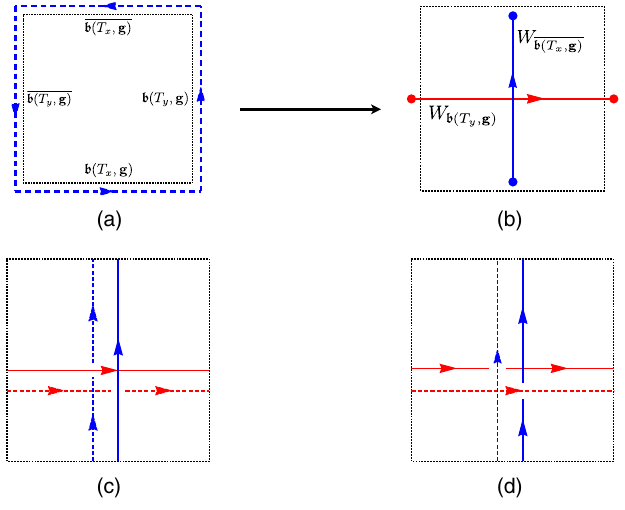
FIG. 7. (a) In the toric code with unconventional symmetry, Z defects exist at the end points of a defect branch line (indicated by the dashed line), which is produced by conjugating the spins on the vertical links on one side of the branch line by σ z for terms in the Hamiltonian that straddle the branch line. This changes − A ↦ þ A for vertex terms straddling the branch line, ener- v v getically favoring an e quasiparticle (indicated by solid black dots) at those vertices. (b) The configuration obtained from that in (a) by acting on the system with the translation operator R (c) The configuration obtained from (a) by adiabatically trans- porting the defect in the ˆ x direction by one lattice spacing. In this case, the topological charge of the defect must change from I e . (d) The configuration obtained from that in (c) by adiabati- Z cally transporting the defect in the ˆ x direction by one lattice spacing. In this case, the configuration of the physical system is unchanged, but is interpreted differently. (e) The configuration obtained from that in (c) by adiabatically transporting the defect in the ˆ y direction by one lattice spacing.